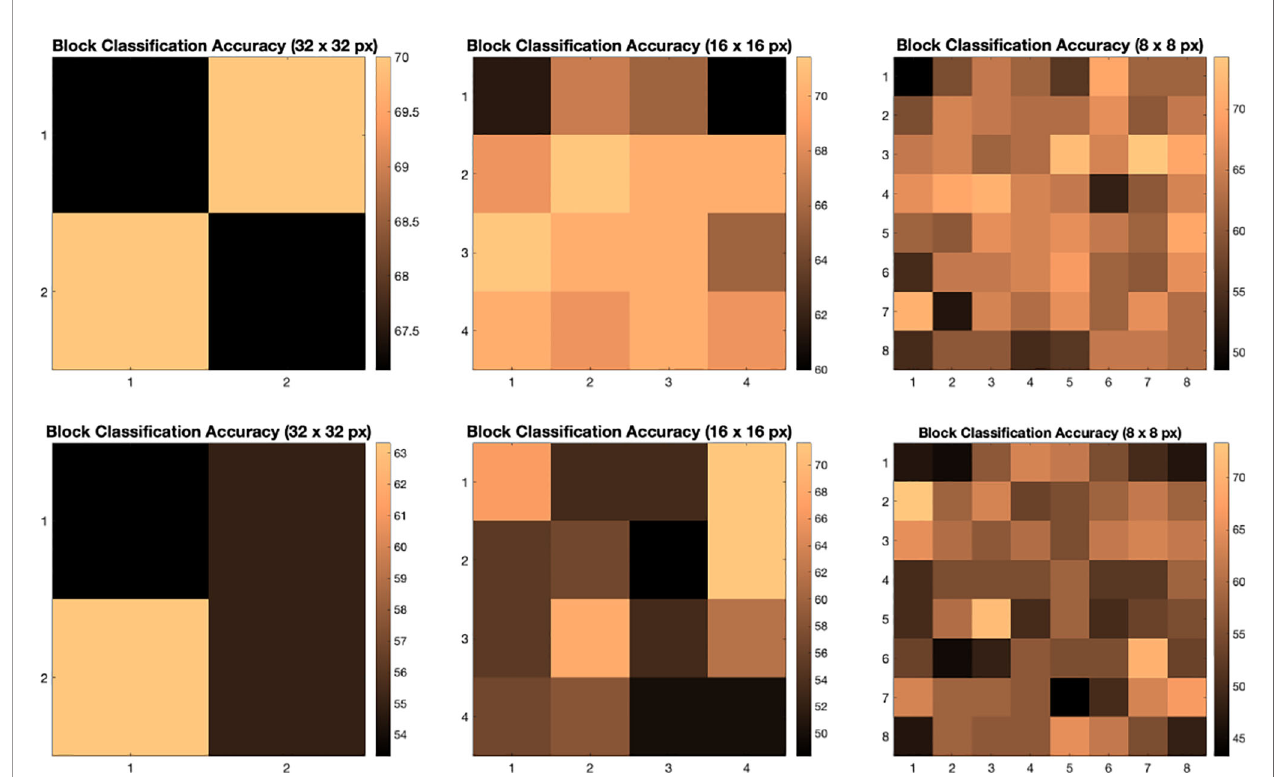
FIGURE 4 | Classi fi cation accuracy by block for 32 × 32, 16 × 16, and 8 × 8 block experiments performed on the MIAS dataset for 10 fold CV (top row) and 30 fold CV (bottom row). The corresponding ensemble BBMAP-S and BBLL-S classi fi cation decision ACCs for 10-fold experiment examples are 70.00%, 70.00%, 70.00%, and 70.00%, 70.00%, 71.43% respectively for 32, 16, and 8 blocks. The corresponding ensemble BBMAP-S and BBLL-S classi fi cation decision ACCs for 30-fold experiment examples are 53.33%, 48.33%, 66.67%, and 80%, 90%, 90% respectively for 32, 16, and 8